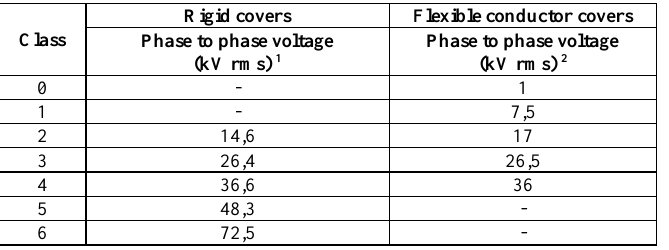
Table 1: Classes of rigid and flexible conductor covers according to their electrical limits.